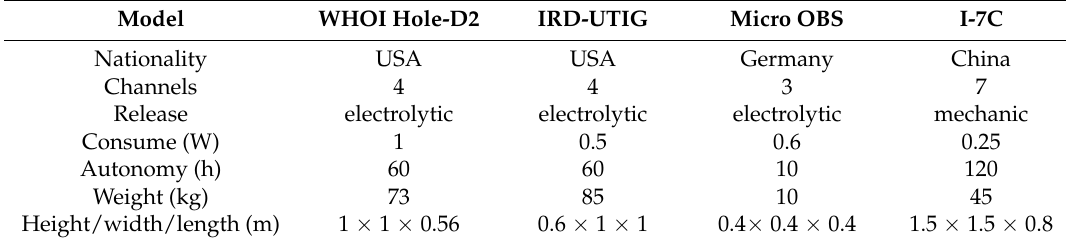
Figure 3. The acoustic wave around the OBS placed on the seafloor.